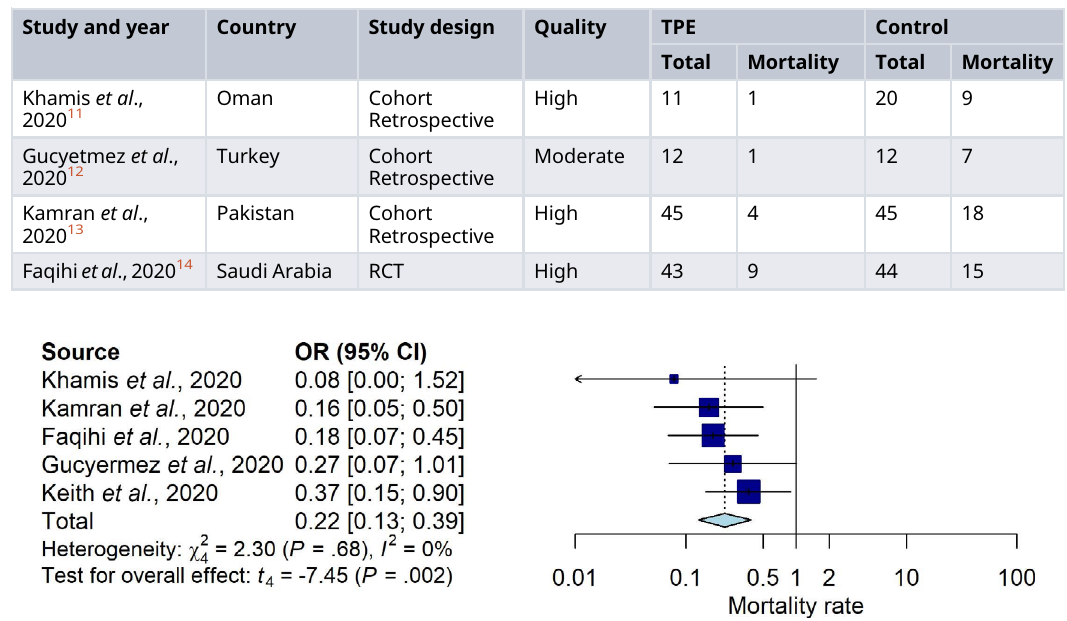
Table 1. Baseline characteristics of articles included in our study.